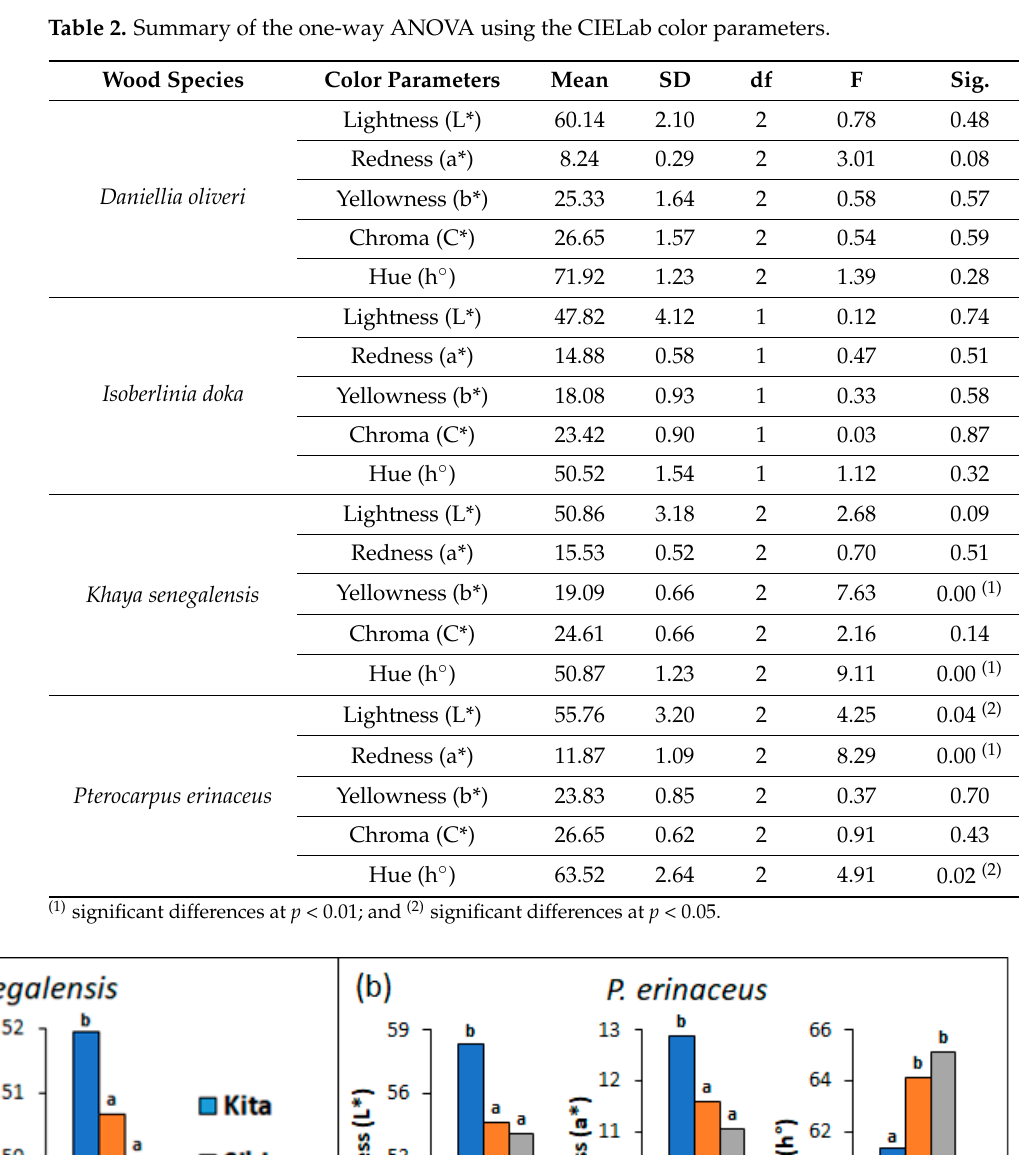
Table 2. Summary of the one-way ANOVA using the CIELab color parameters. Wood Species Color Parameters Mean